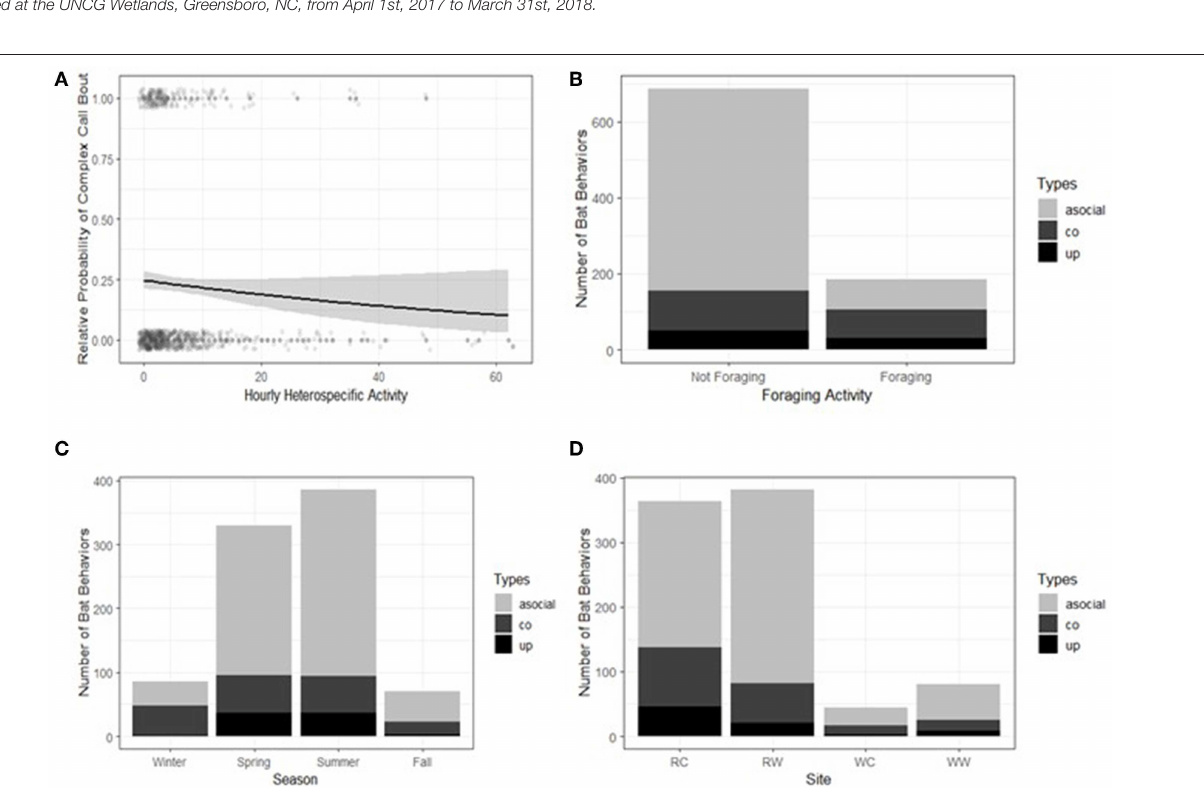
FIGURE 3 | Context of Eptesicus fuscus social call bouts compared to the context of bat passes without social calls. (A) Probability of complex call bouts relative to passes without social calls was negatively correlated with heterospecific activity, (B) social call bout production varied with presence of foraging buzzes, (C) social call bout production varied with season, and (D) social call bout production varied with site. Bout type abbreviations: co, complex bouts; up, upsweep bouts. Site abbreviations: RC, recreational field control; RW, recreational field wetland; WC, woodland control; WC, woodland wetland. Calls were collected at the